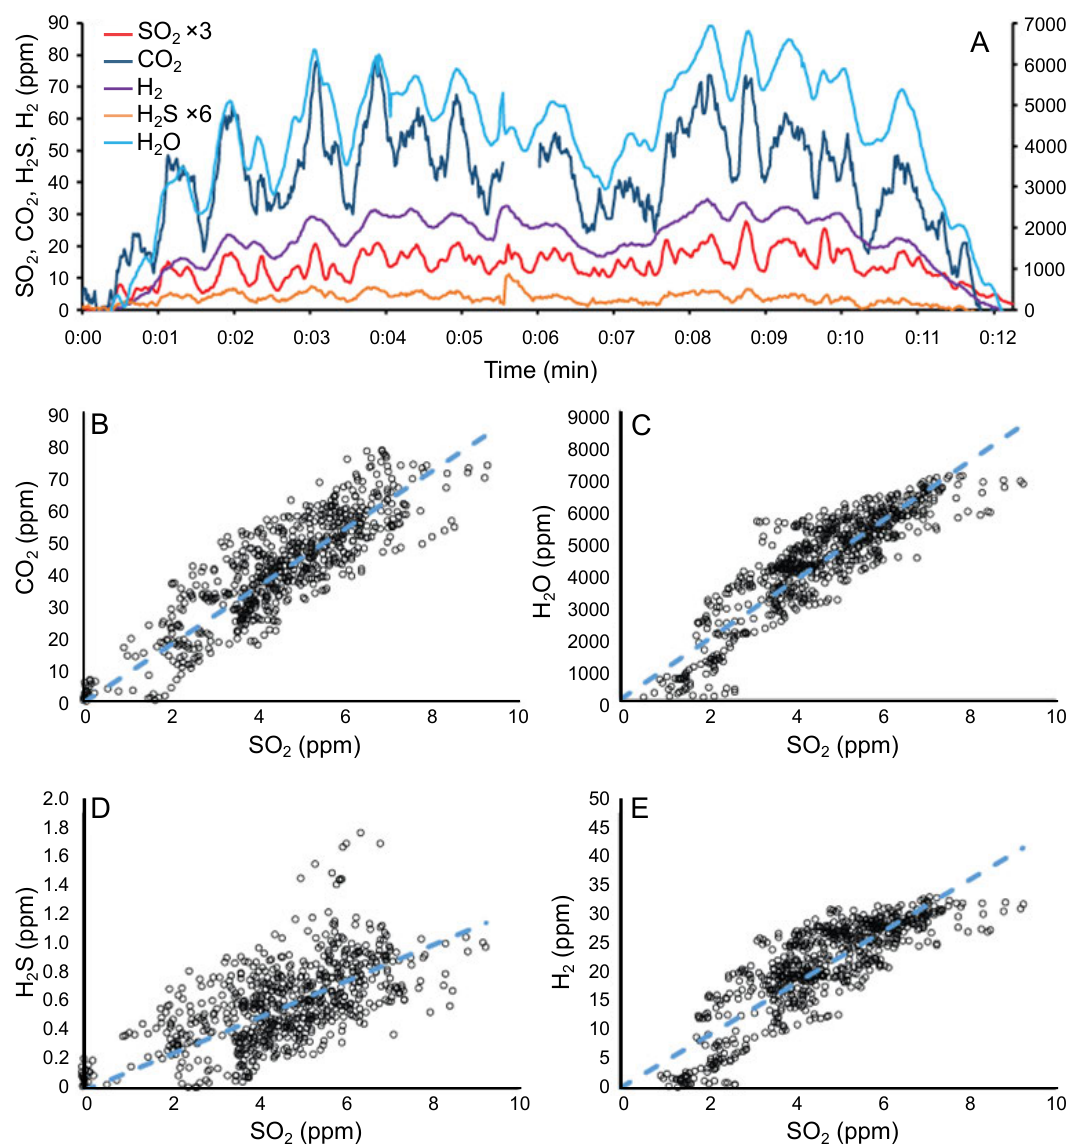
Figure 4: [A] Plume mixing ratios measurements taken on 13 January 2016 for 12 min at an acquisition frequency of 1 Hz. All data are after correction of background atmospheric amounts. Note that in [A], H the right vertical axis while other gases are reported on the left axis. The small data gap in the CO due to removal of a 30 s period where the operator approached the unit, which has recorded exhaled